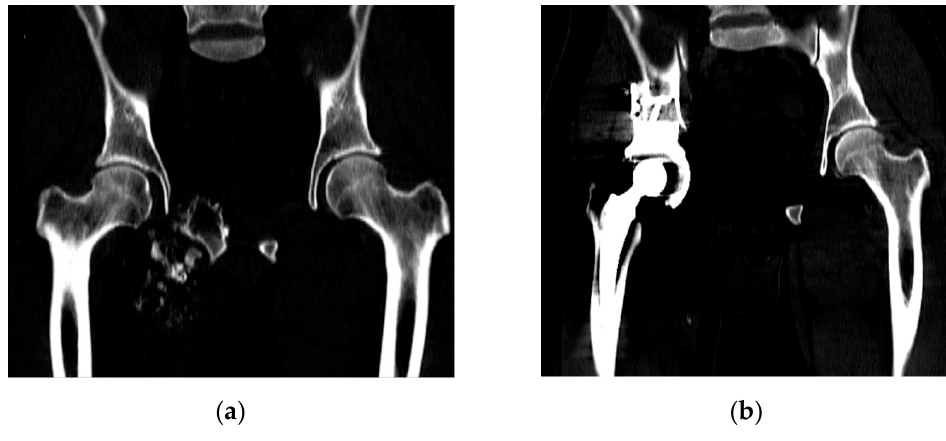
Figure 3. CT images: ( a ) before surgery; ( b ) after surgery.